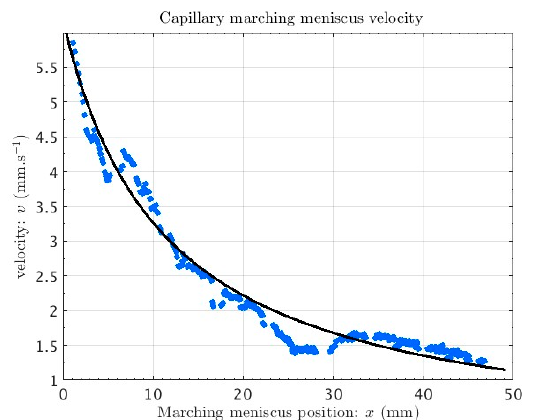
Figure 5. Speed of the advancing liquid meniscus vs. position (test